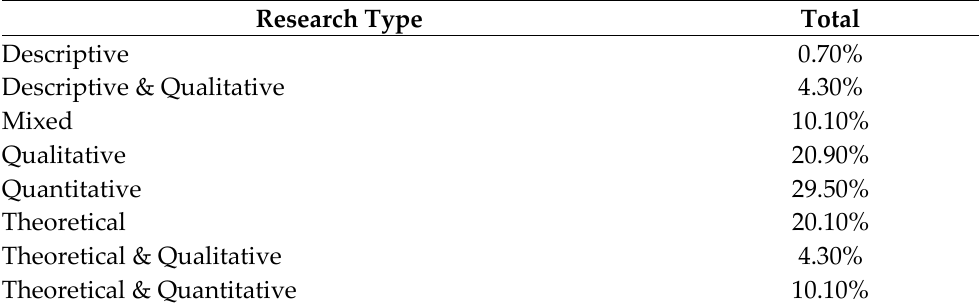
Table 3. Research types.